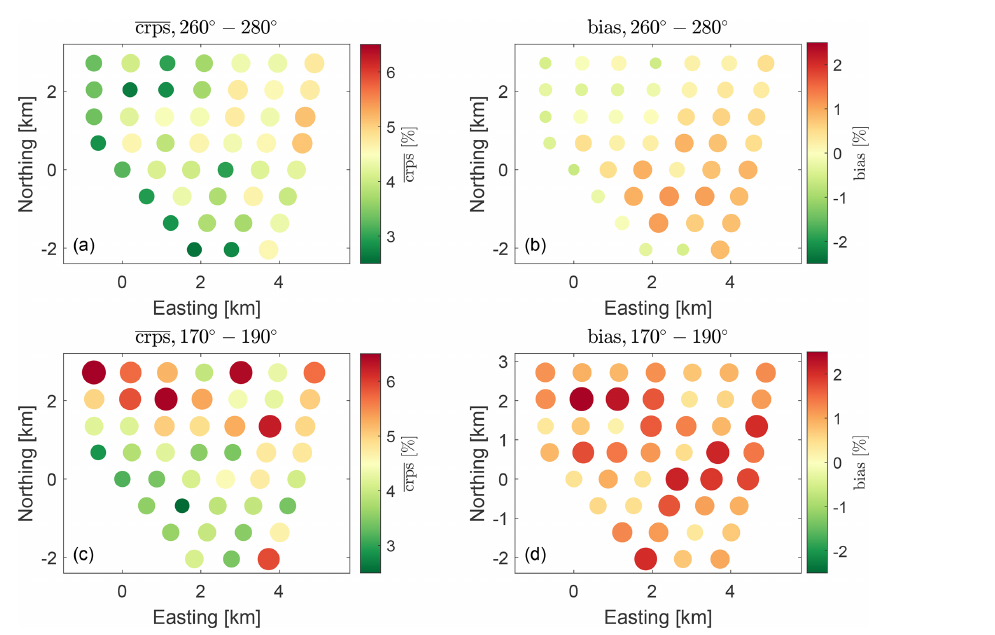
Figure 5. The crps and bias of the LF for turbines GT30–GT75 in percent of rated power for stable atmospheric conditions, situations below rated power, and wind directions of (a, b) 260–280 ◦ and (c, d) 170–190 ◦ . The colour scale and magnitude of the dots visualize the magnitude of the scores.